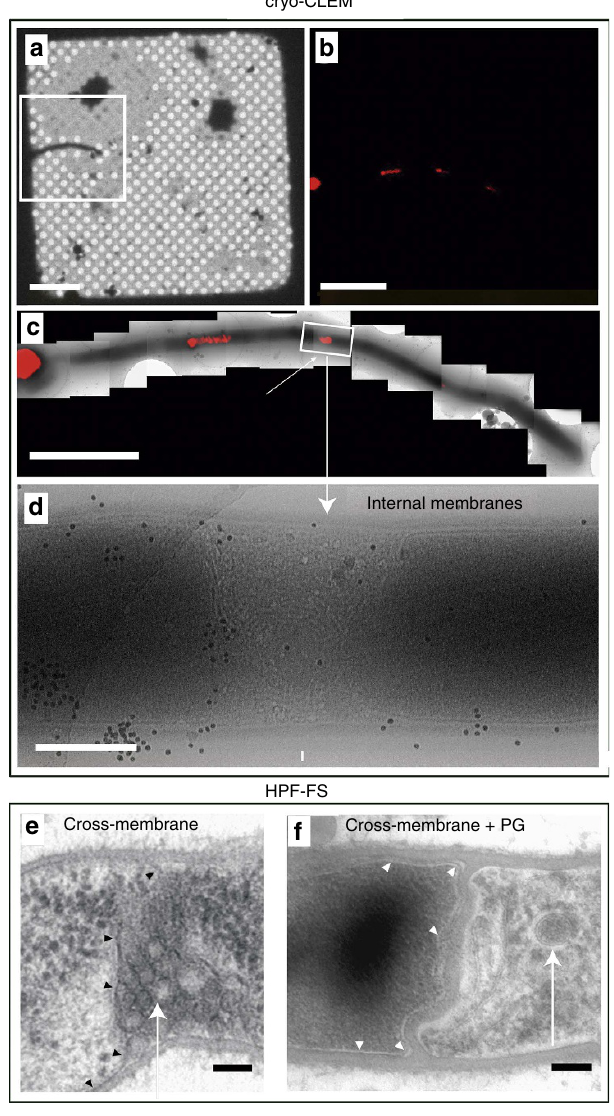
Figure 3 | Cryo-correlative light and electron microscopy (cryo-CLEM) and high-pressure freezing and freeze substitution (HPF-FS) of 12-hour MI hyphae of S. coelicolor grown on GYM agar. ( a – d ) Cryo-CLEM. ( a ) Phase-contrast mode, ( b , c ) FM5-95 (red) staining, ( d ) electron microscopy. ( e , f ) HPF-FS electron microscopy, ( e ) cross-membrane without cell wall, ( f ) cross-membrane with a thick cell wall. Arrows indicate internal cross-membranes in the form of membrane vesicles and membrane arrays. Arrowheads indicate cross-membranes continuous with the extracellular membrane delimiting cellular segments. Scale bars: ( a ) 20 m